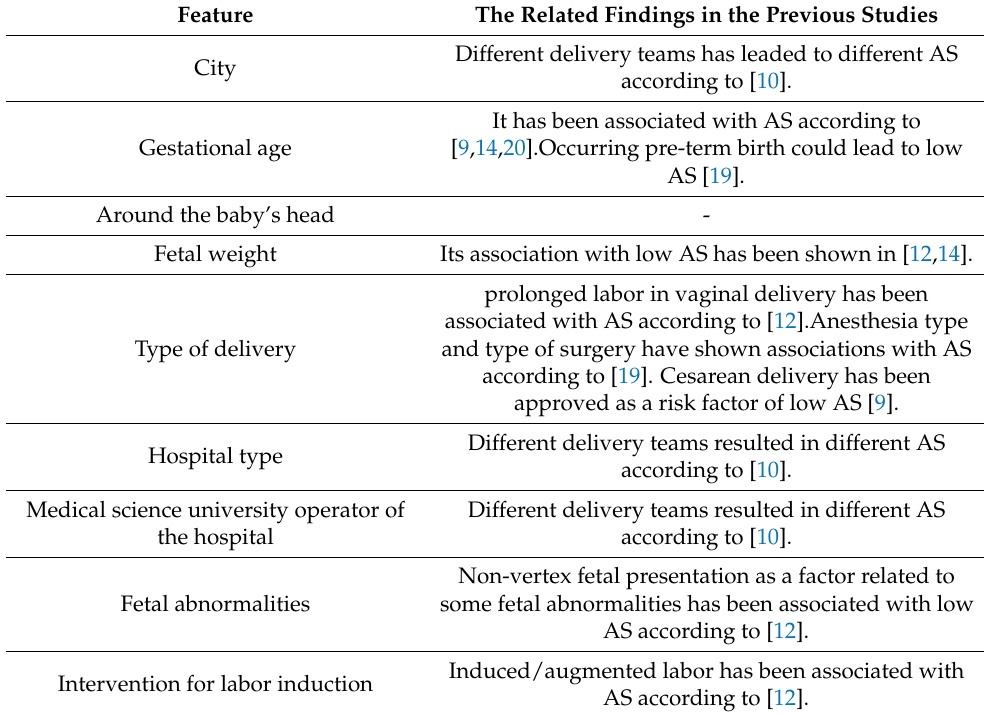
study for Apgar score